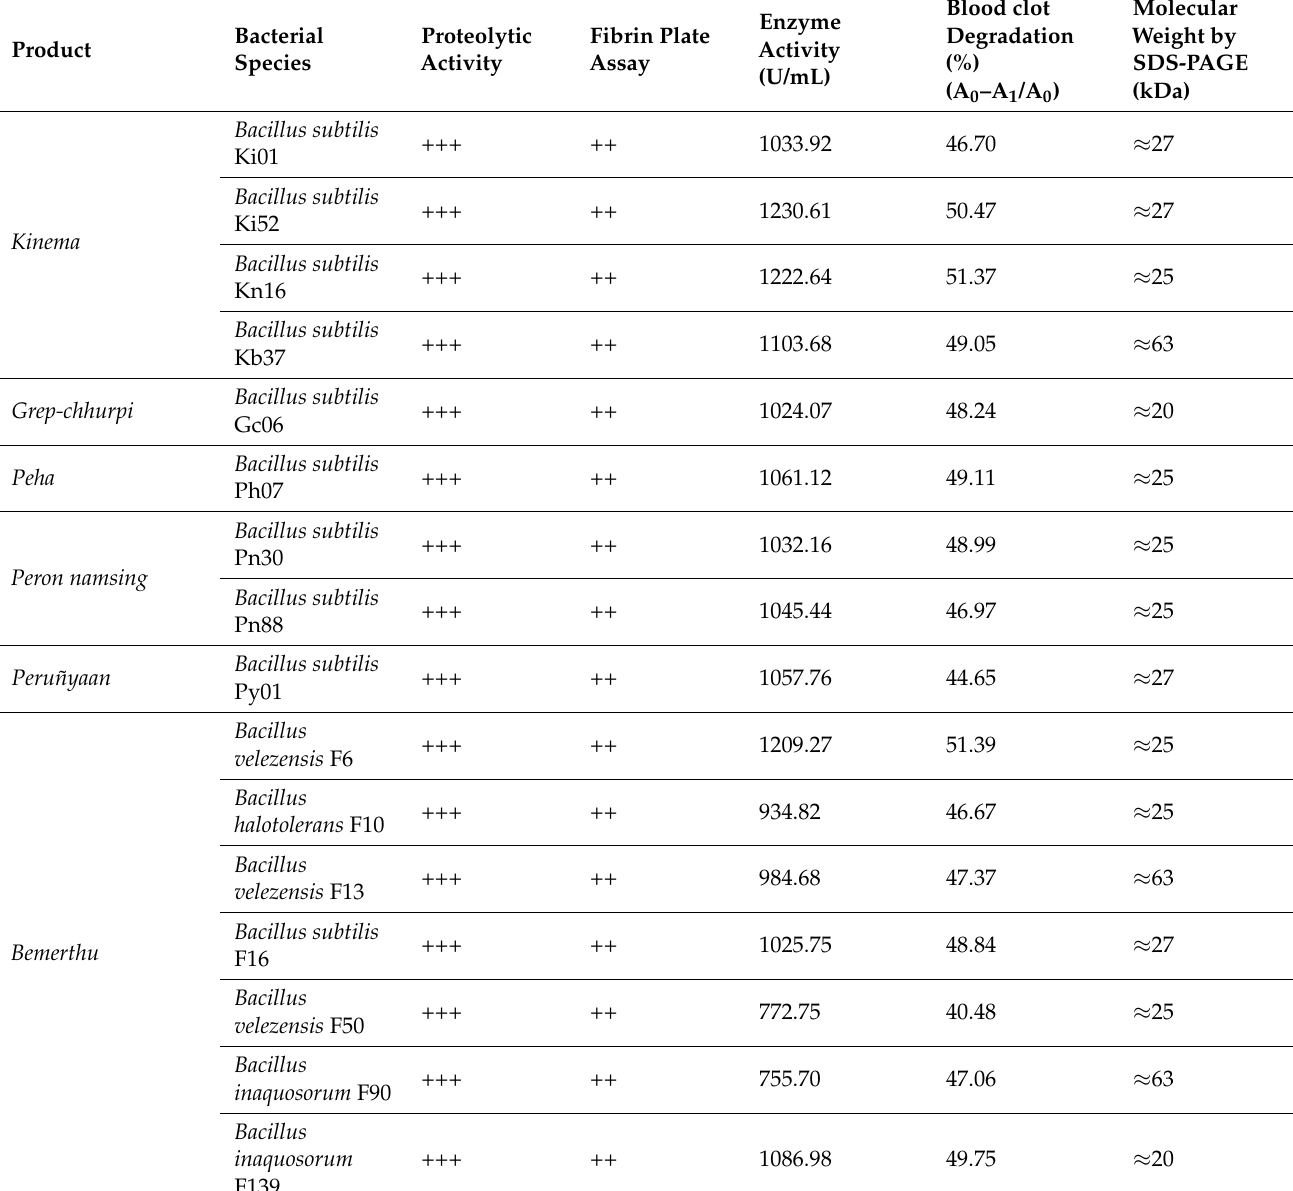
Table 4. In vitro fibrinolytic properties of Bacillus strains isolated from the Himalayan fermented soybean